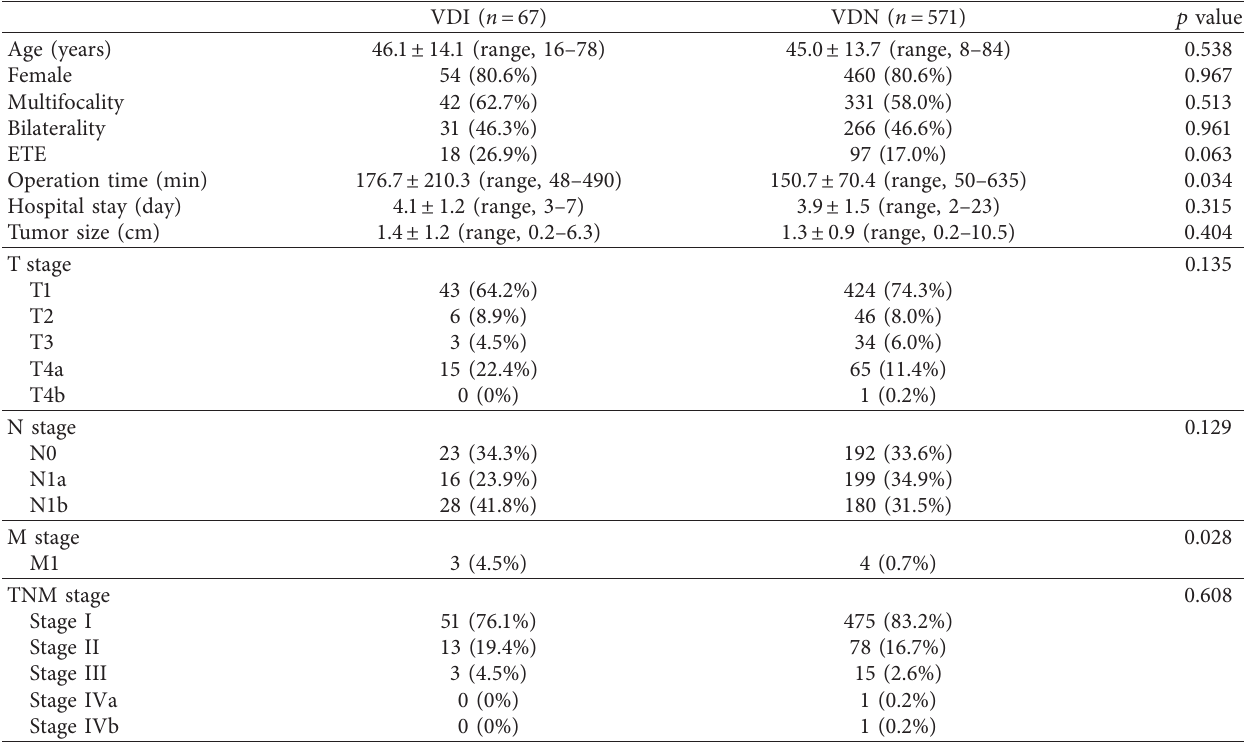
Table 3: Comparison of baseline clinicopathologic characteristics of patients with transient hypocalcemia between vitamin D3 injection (VDI) and vitamin D3 noninjection (VDN)